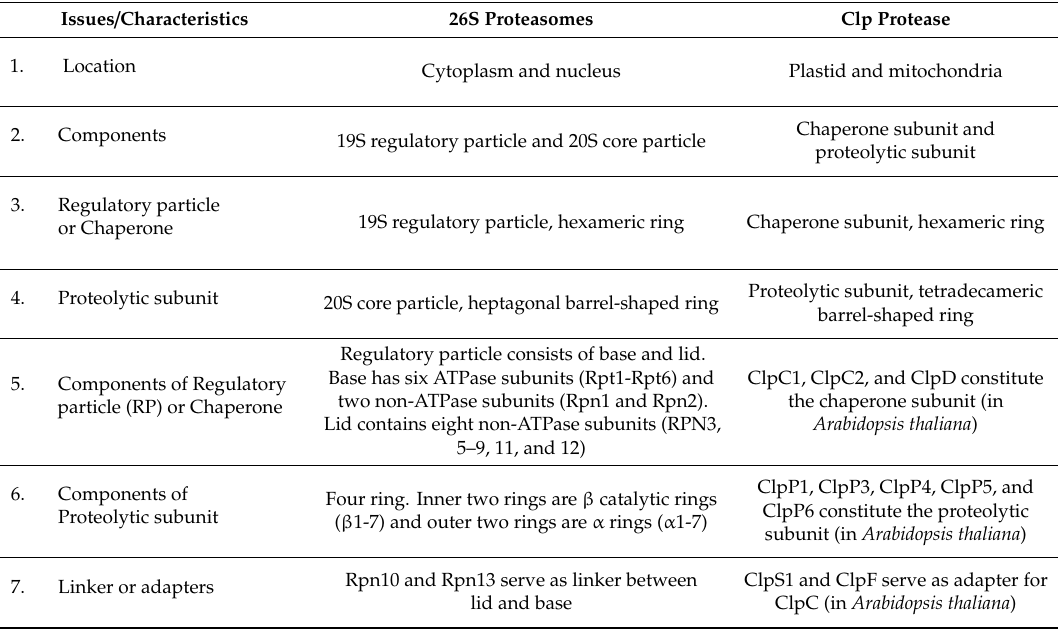
Figure 2. Schematic representation of ATP-powered proteolysis in plastids of plant cells. Misfolded proteins are recognized, unfolded, and translocated to the proteolytic chamber of the Clp protease complex by ClpC chaperones. The translocated proteins are degraded to oligopeptides that are exported through openings of the proteolytic chamber. Table 1. Comparison between 26S proteasomes and Clp protease.